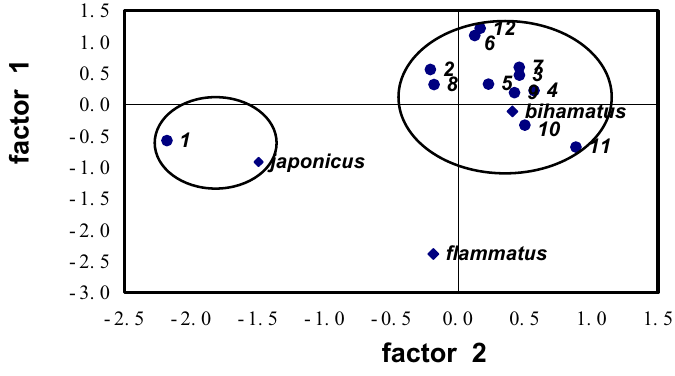
Fig. 1 – Principal Components Analysis of Tibicen species using the peak and mean frequencies and pulse rate as the variables.